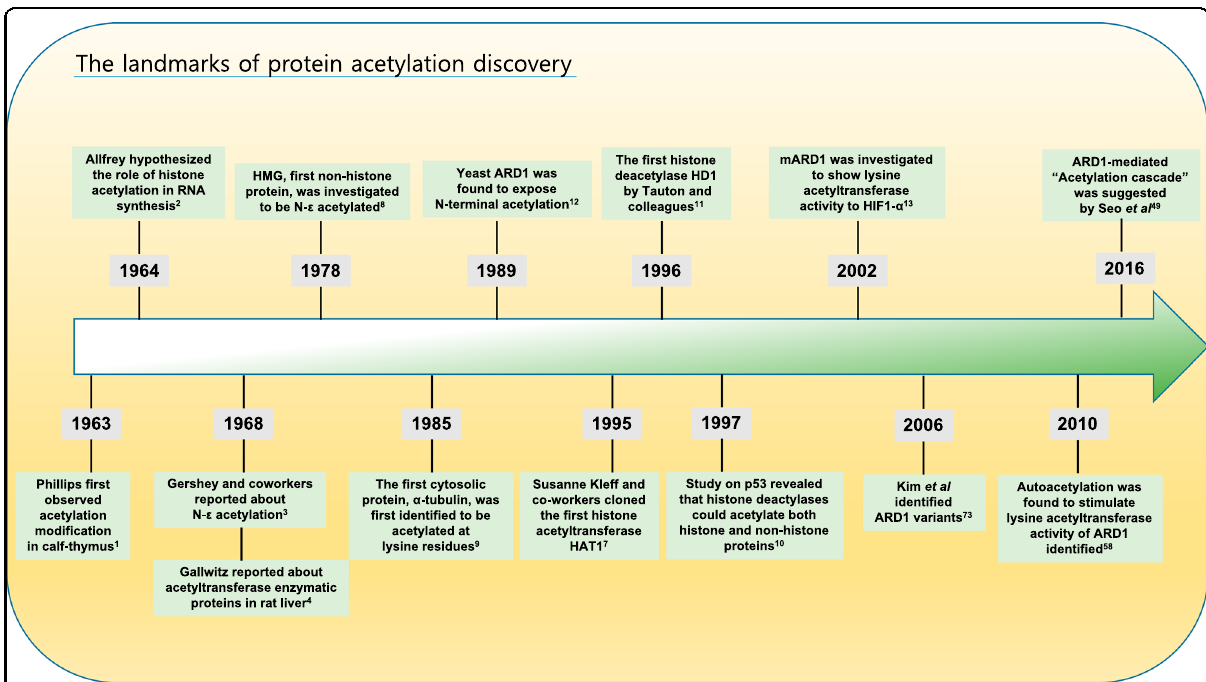
Fig. 1 Timeline of breakthroughs that laid the foundation for the development of protein acetylation studies in developmental and pathological